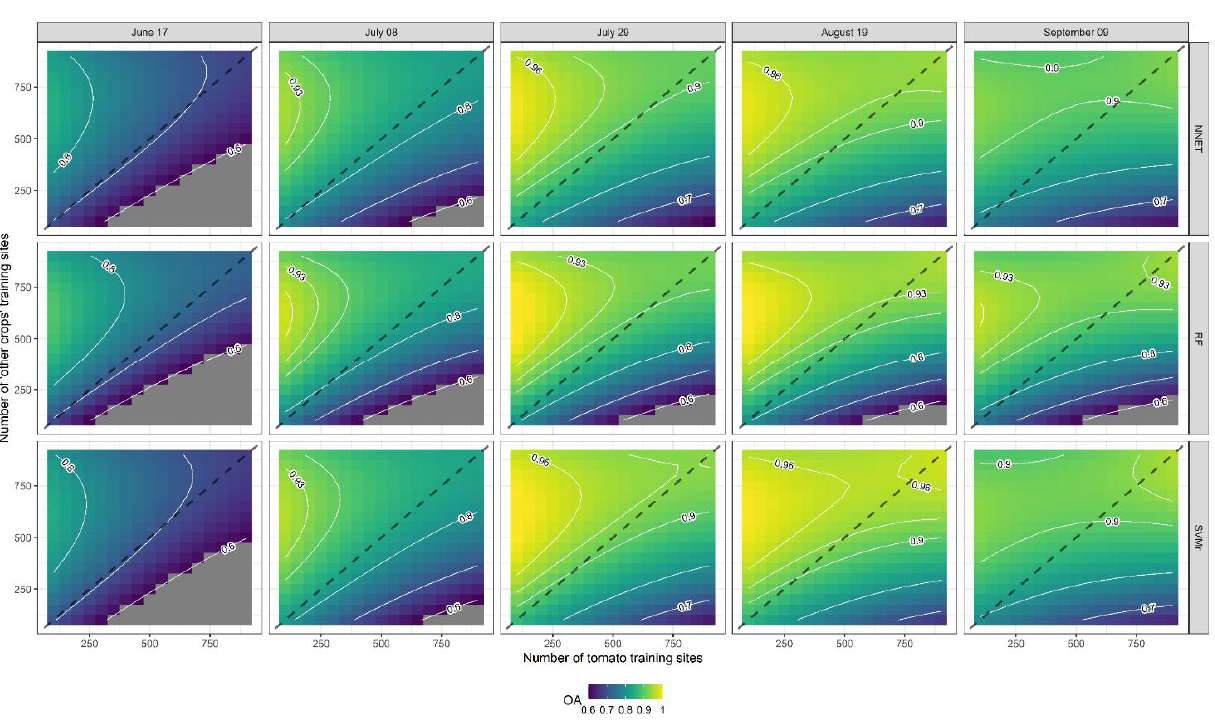
Figure 8. Response contour plots for Overall Accuracy (OA) as a function of the number of tomato training sites (X 1 ) and the number of other crop training sites (X 2 ). The dashed line represents a 1:1 line between X 1 and X 2.